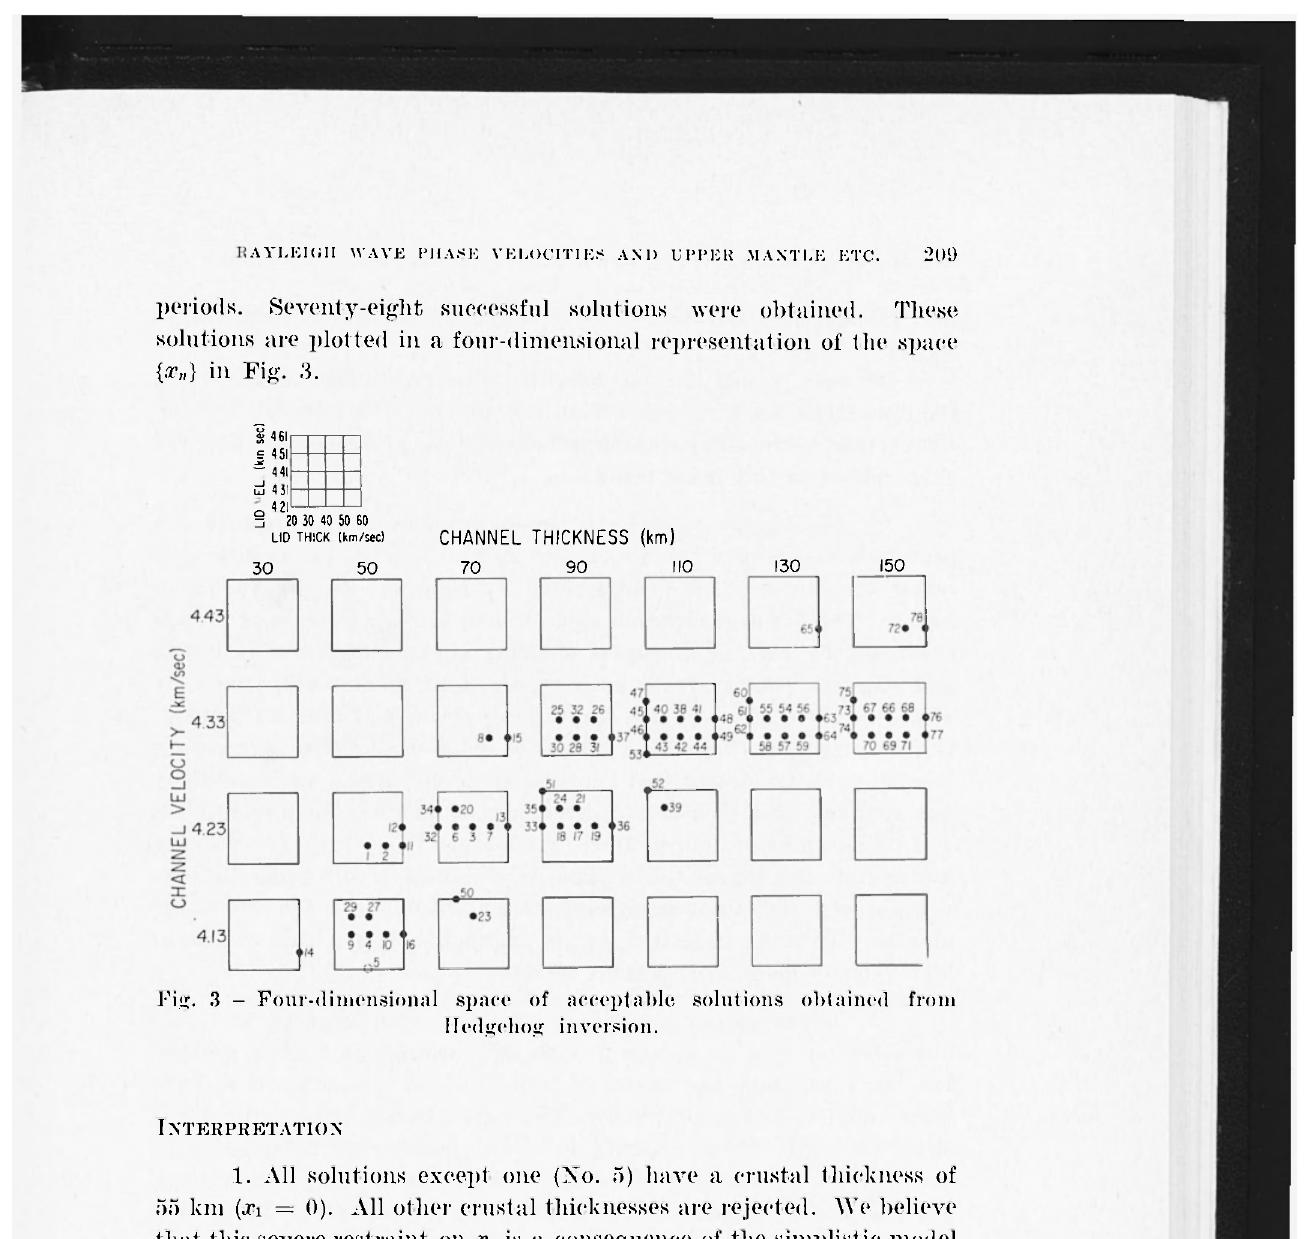
Fig. 3 — Four-dimensional space of acceptable solutions obtained from Hedgehog